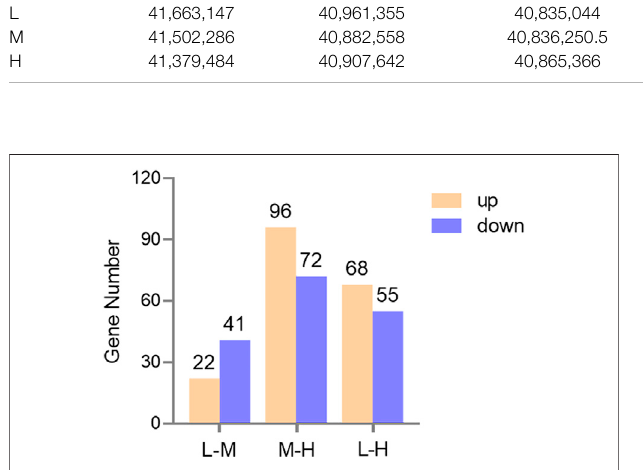
FIGURE 5 | Bar graph of the DEGs in three comparisons. Yellow and blue represent upregulated and downregulated gene numbers,